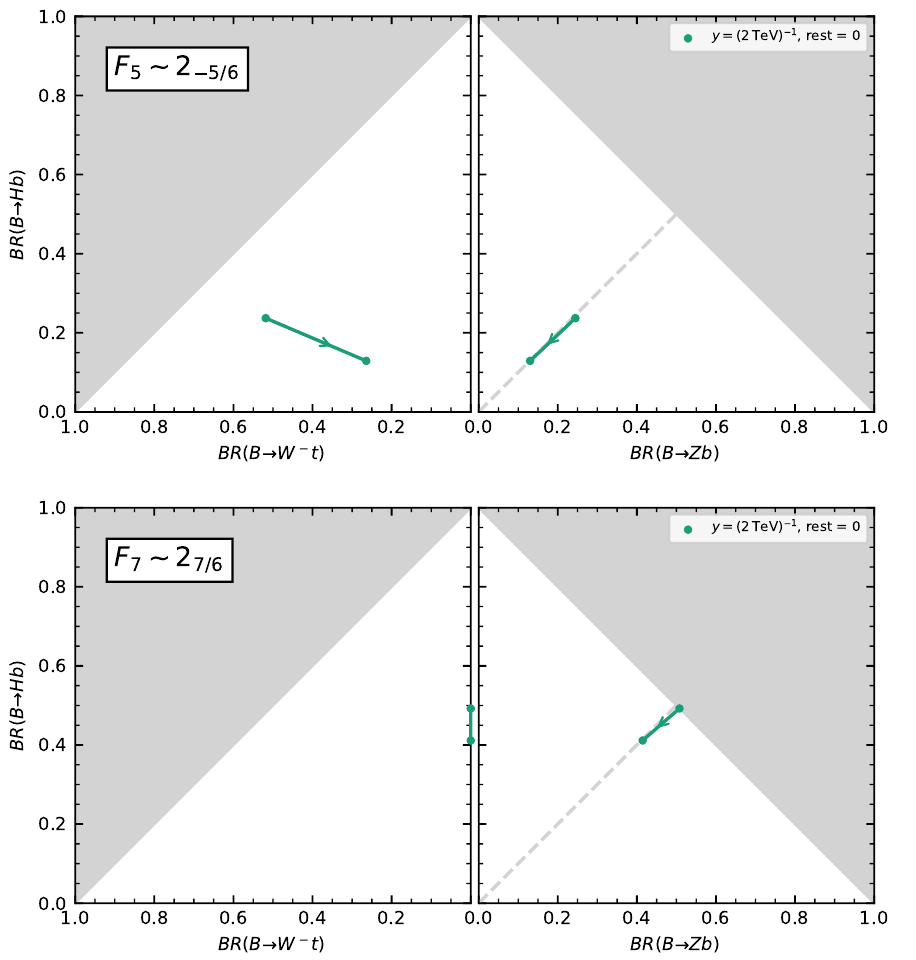
Figure 17 . Branching ratios of T into Ht , Zt and W (cid:0) t for various values of the parameters in the F 1 and F 5